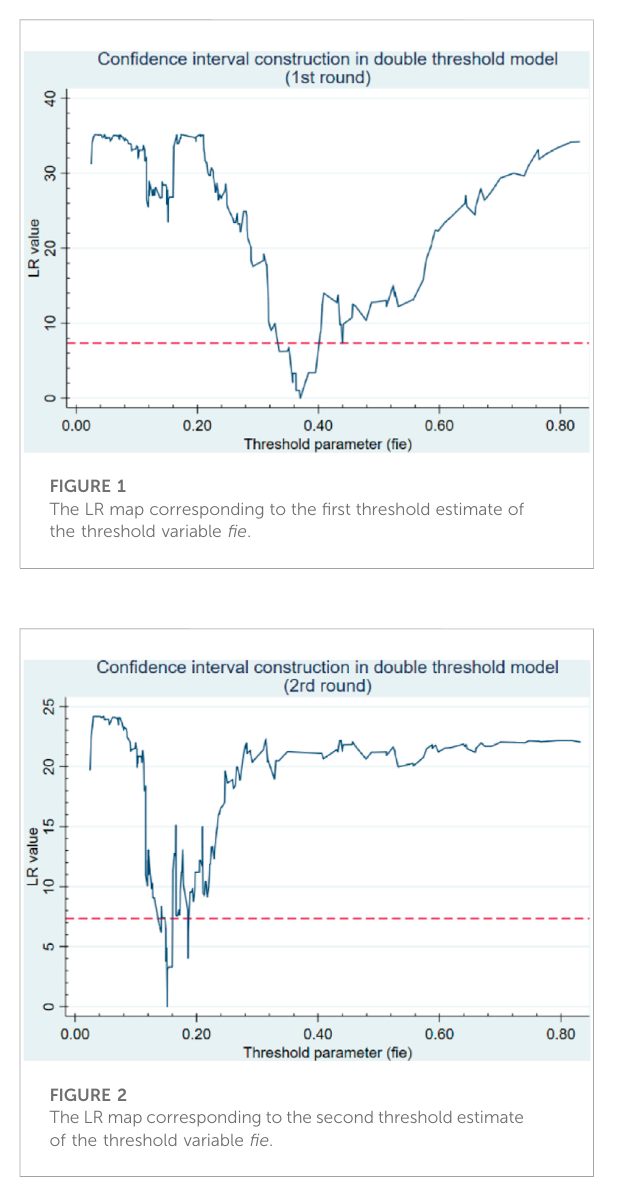
FIGURE 4 The LR map corresponding to the second threshold estimate of the threshold variable iie